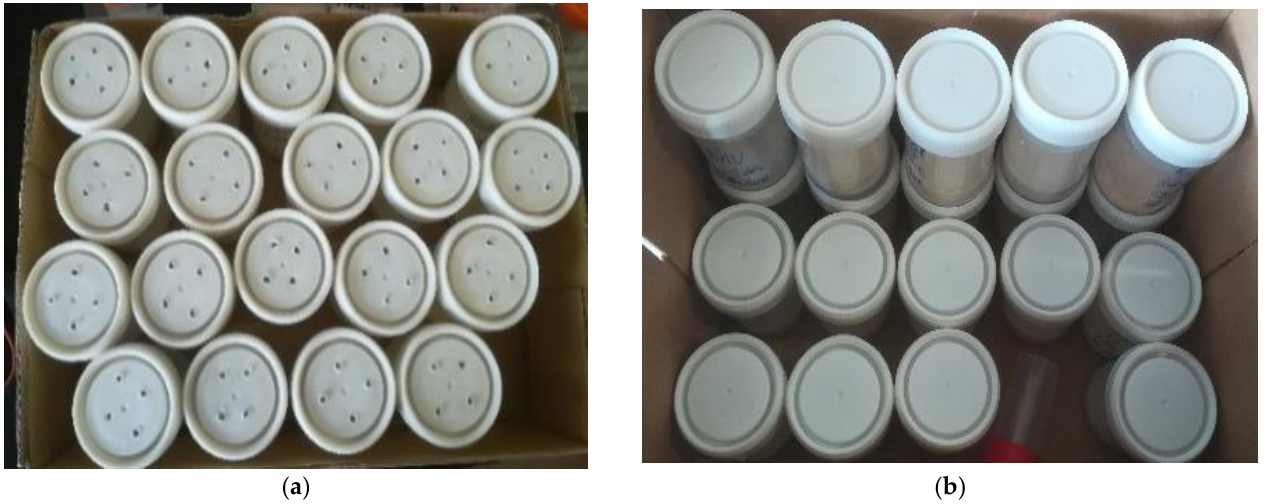
Figure 4. ( a ) Samples exposed to air, ( b ) samples not exposed to air.